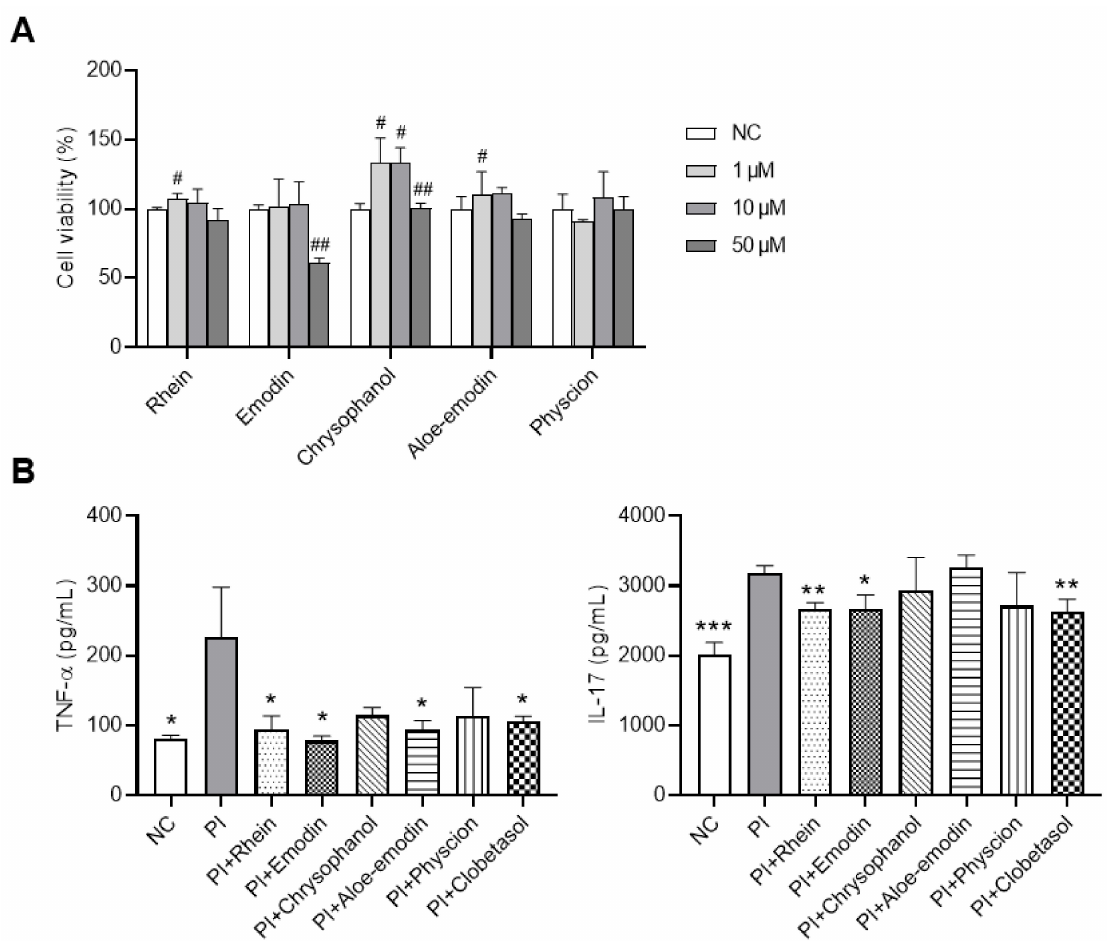
Figure 6. Effects of RPE compounds on the inflammatory response in PI-stimulated EL-4 cells. ( A ) EL- 4 cell viability was assessed using XTT assays. ( B ) Effects of RPE compounds on the production of TNF- α and IL-17 in EL-4 cells stimulated with PI (10 ng/mL PMA and 100 ng/mL ionomycin). Data are expressed as means ± SDs ( n = 3 per experiment). # p < 0.05, ## p < 0.01 vs. normal control (NC); * p < 0.05, ** p < 0.01, *** p < 0.001 vs. PI-treated